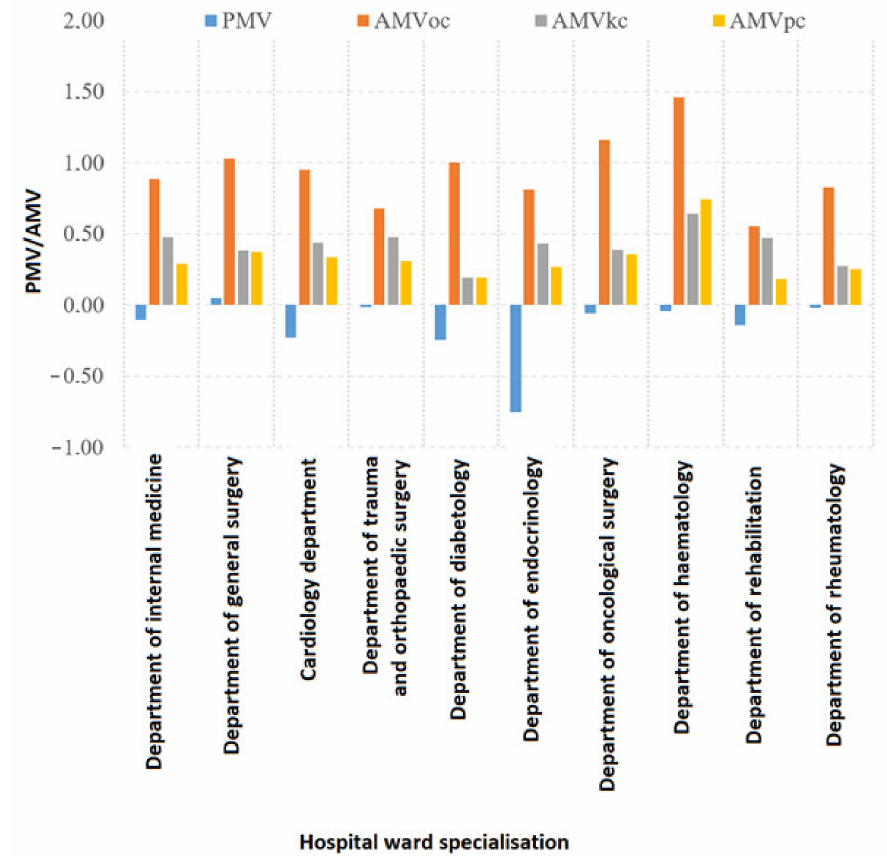
Figure 4. Predicted mean value of thermal conditions vs. actual mean value of thermal conditions, depending on different specialities of wards